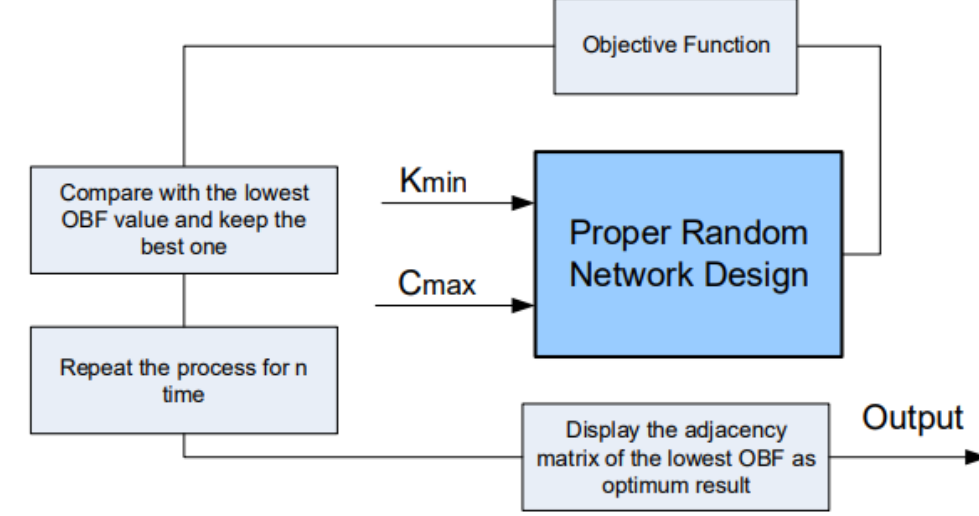
Figure 18. Flowchart for the Optimum Network Design.